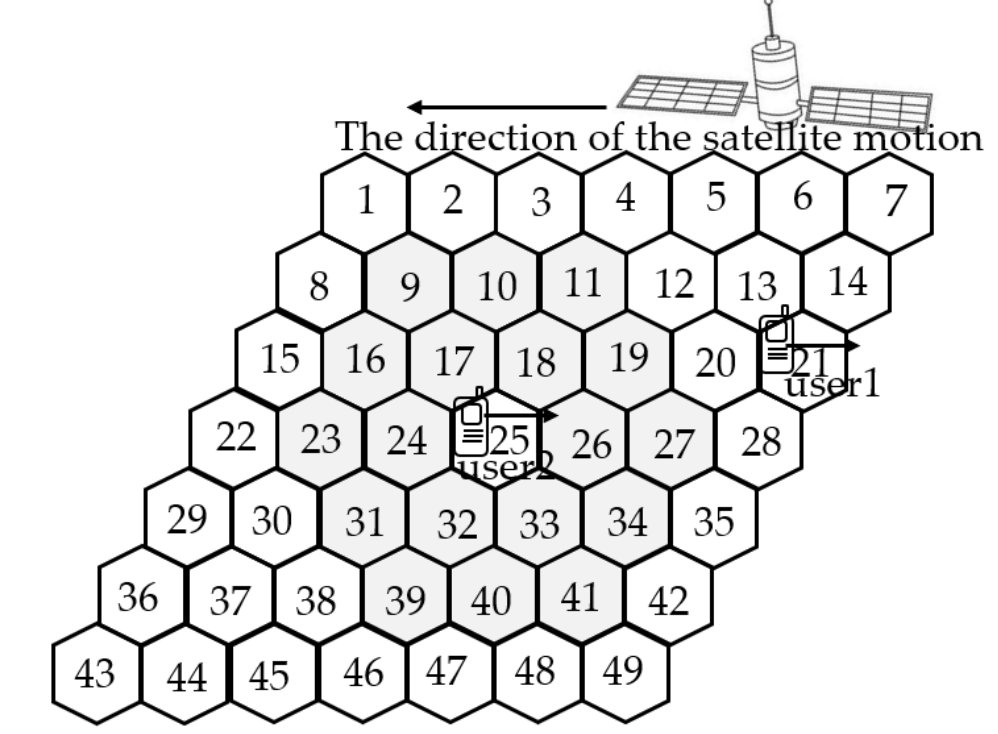
Figure 1. The mobility model of the users.